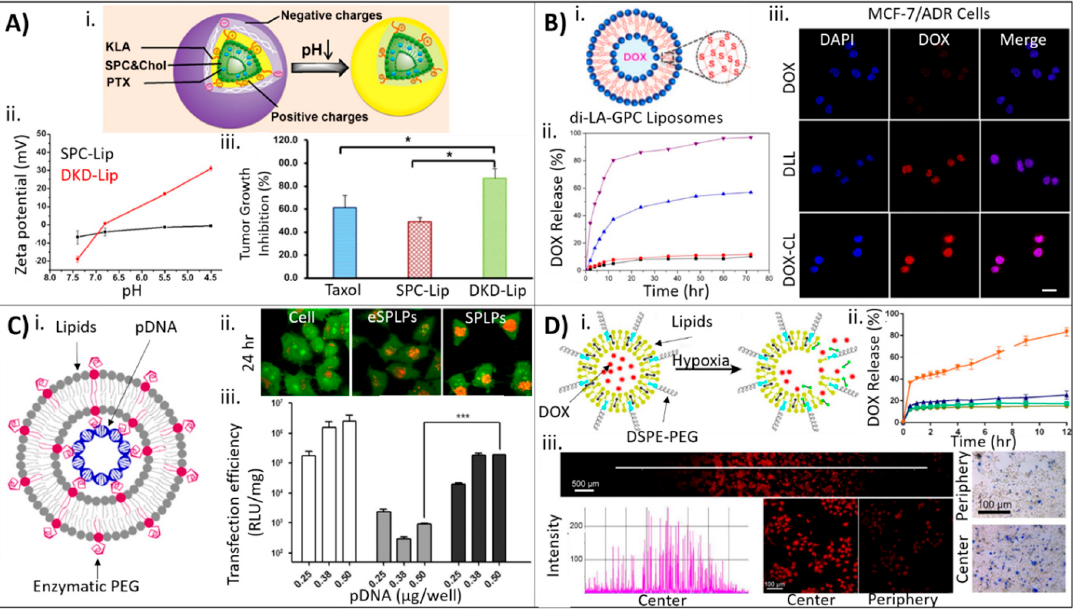
Figure 3. Drug incorporation during and after liposome synthesis. ( A ) ( i ) Illustration of DKD liposomes depicting change in surface charge from negative to positive with decreasing pH in the tumor microenvironment. ( ii ) Changes in zeta potential for non-reactive liposomes (black line) and DKD liposomes (red line) track with pH. ( iii ) Tumor growth inhibition for Taxol ® (blue), non-reactive liposomes (red), and DKD liposomes (green) shows inhibition of tumor growth for DKD liposomes (* p < 0.05). Image adapted from Jiang © Elsevier (2015) Ref. [44]. ( B ) ( i ) Schematic of di-LA-GPC cross-linked liposomes with DOX loaded into the core. ( ii ) DOX release for cross-linked liposomes ( + GSH, purple), cross-linked liposomes (-GSH, red), non-cross-linked liposomes (blue), and Doxil ® -like liposomes (black) shows only cross-linked liposomes ( + GSH) and non-cross-linked liposomes release DOX. ( iii ) DOX-resistant MCF-7 cells treated with free DOX (top), Doxil ® -like liposomes (middle), and cross-linked liposomes (bottom) show the greatest DOX release from cross-linked liposomes. Image adapted from Ling © Elsevier (2019) Ref. [46] . ( C ) ( i ) Schematic of enzyme- responsive liposomes loaded with plasmid DNA. ( ii ) Acridine orange assay for endolysomal disruption at 24 h for untreated cells only, enzymatically-responsive liposomes, and non-responsive liposomes showing decreased endosomal staining (orange) in responsive liposomes compared to non-responsive liposomes suggesting endosomal escape. ( iii ) Transfection efficiency of lipofectamine (white bars), non-responsive liposomes (gray bars), and enzyme-responsive liposomes (black bars) shows increased transfection efficiency (*** p < 0.001) for responsive liposomes. Image is from Song © Elsevier (2016) Ref. [49] . ( D ) ( i ) Schematic illustration of liposomes loaded with DOX showing disruption of liposomes in the presence of hypoxic cells via reduction of the nitroimidazole derivative. ( ii ) Cumulative DOX release over time for responsive liposomes in hypoxia (orange), responsive liposomes in normoxia (blue), non-responsive liposomes in hypoxia (green), and non-responsive liposomes in normoxia (yellow). ( iii ) FaDu cells cultured in conditions of normoxia at the periphery of the dish and hypoxia in the center show increased DOX release (red, left) and increased cell death (Trypan blue, right) in the center. Scale bare, 500 um (left) and 100 um (right). Image from Li © Elsevier (2019) Ref. [54] . 3.3. Drug Incorporation Using Covalent Conjugation The covalent bioconjugation strategy is most often used in the formulation of prodrugs that are capable of self-assembly into liposomes [55–60]. Traditionally, the prodrug consists of a phospholipid that is covalently bound to a drug with a responsive element that mediates liposome degradation and drug release [61]. These liposomes may be further decorated with peptides or antibodies for